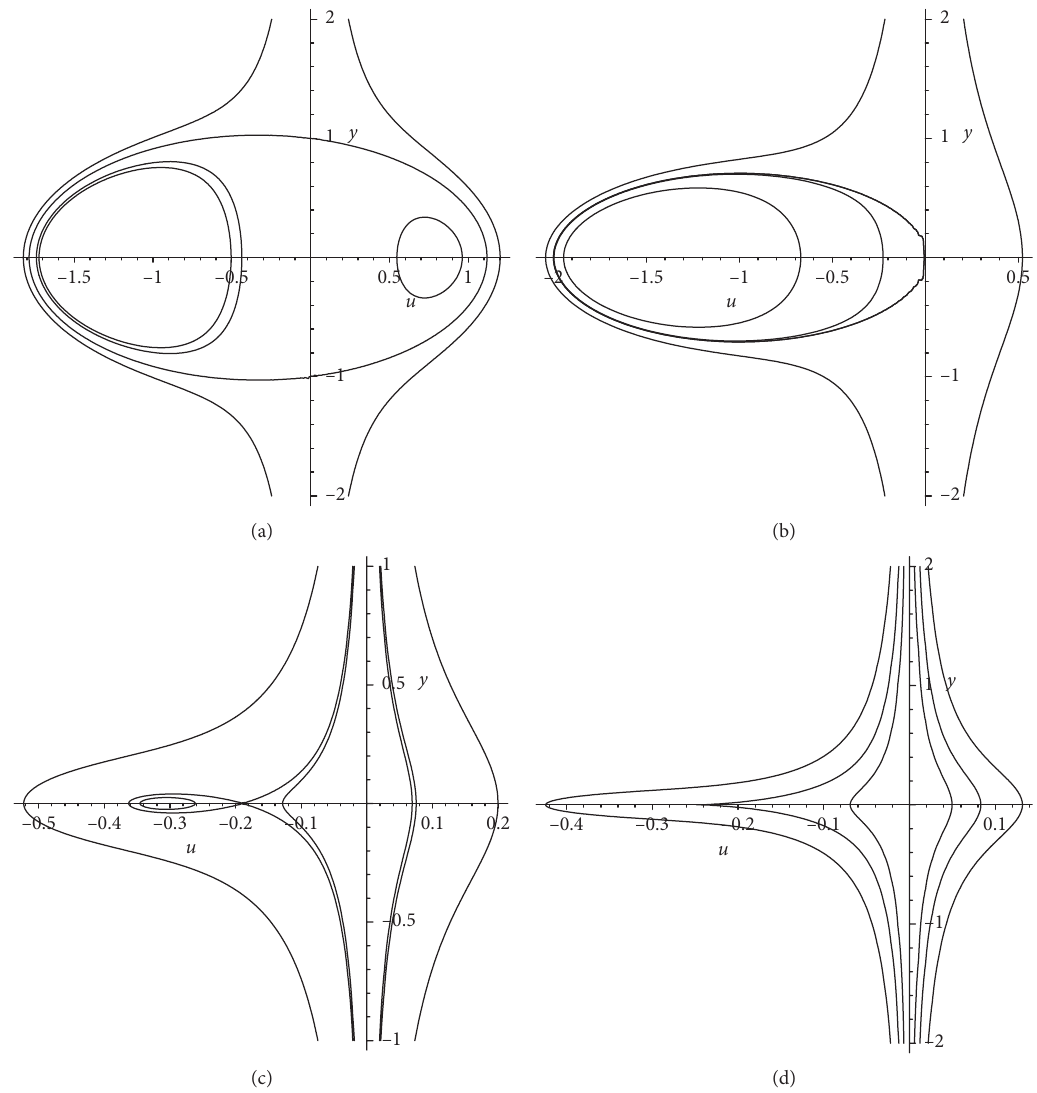
Figure 2: Phase portraits of system (9) when − 1 < c < 0. (a) g < 0. (b) g � 0. (c) 0 < g < g